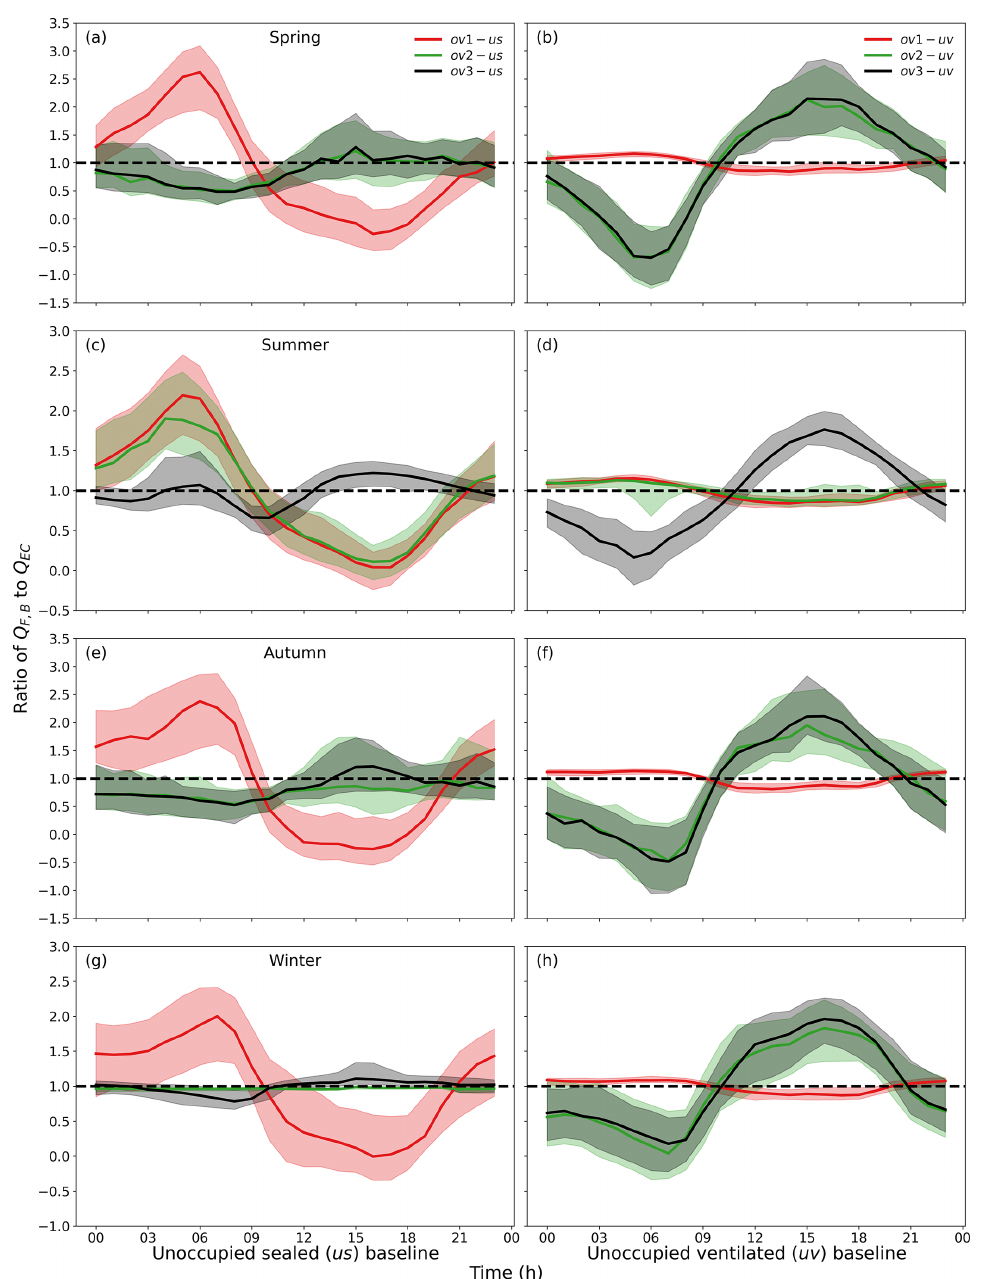
Figure 3. Q F , B to Q EC ratio I median (line) and IQR (shading) for (a–b) spring, (c–d) summer, (e–f) autumn and (g–h) winter, using two unoccupied baselines: (a, c , e, g) sealed (us), and (b, d, f, h) ventilation (uv); each with three occupancy types (colour): ov 1 : only internal heat gains are applied and window is fully open; ov 2 : internal heat gains and natural ventilation control are applied. Ov3: internal heat gains, natural ventilation control and HVAC system are applied. Ratio R = 1 (Black dotted